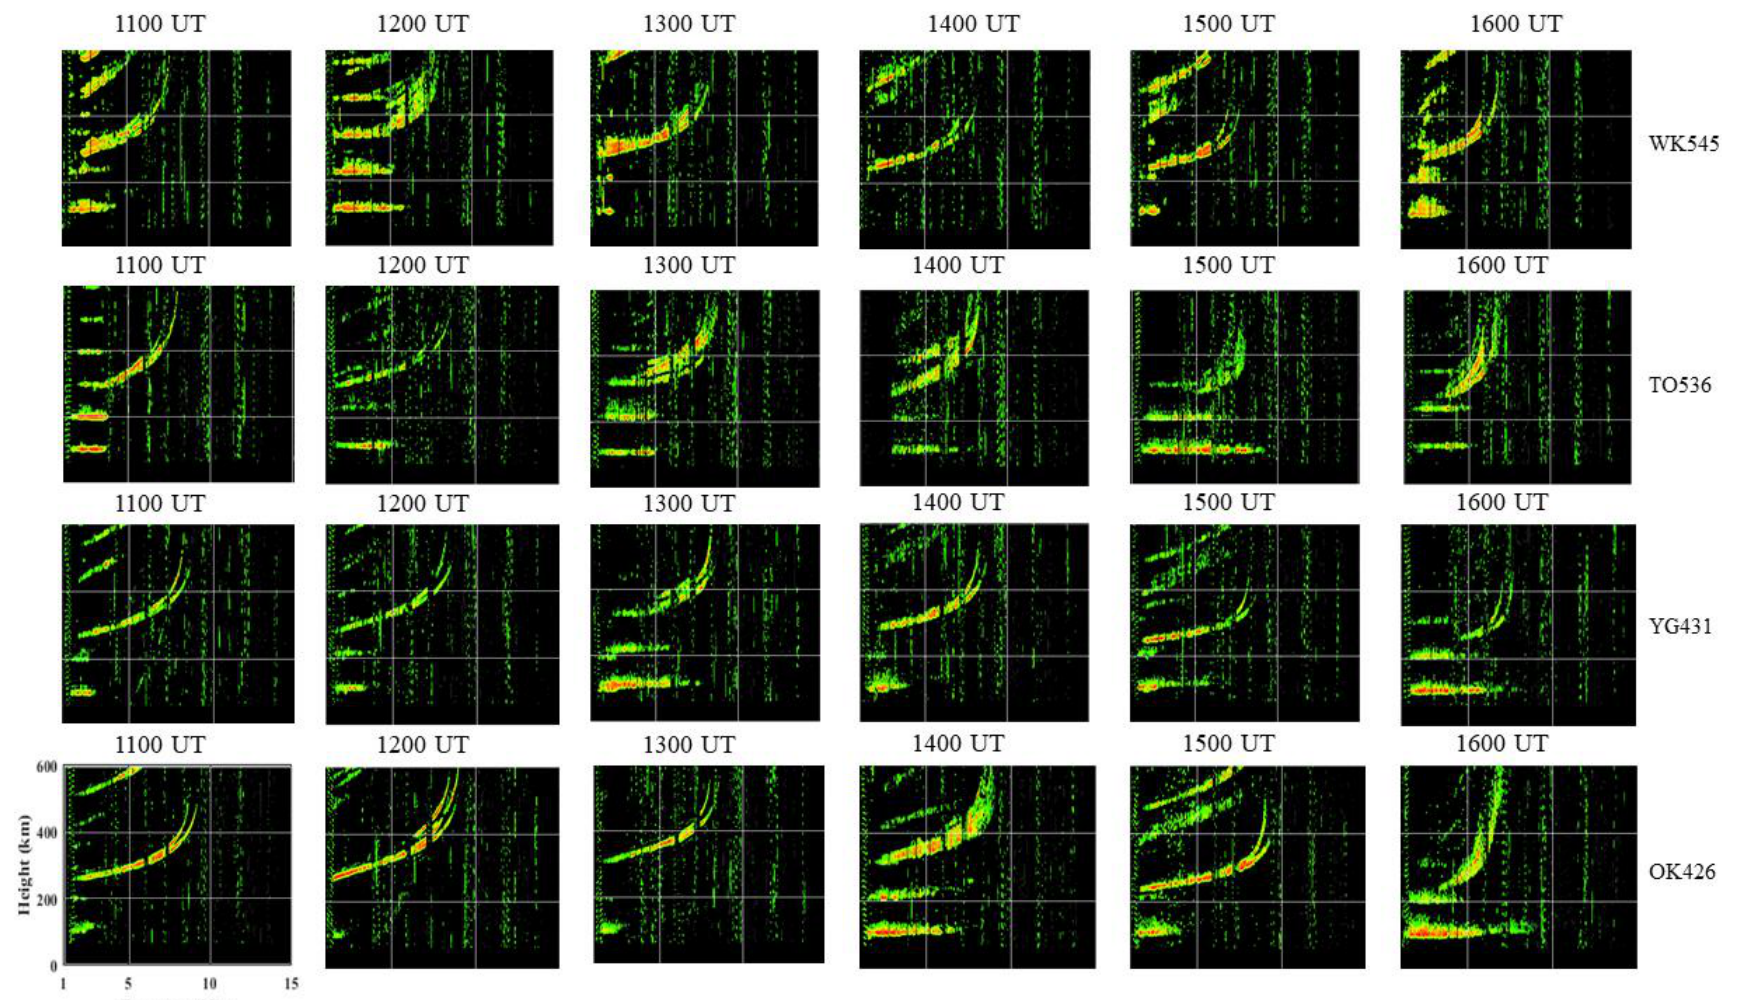
Figure 5. Development of spread F at ( top panel ) WK545, ( second panel ) TO536, ( third panel ) YG431, and ( bottom panel ) OK426 during 11 – 16 UT (20-01 JST) on 15 July 2003. Coordinate reference information is given in the lower left figure.